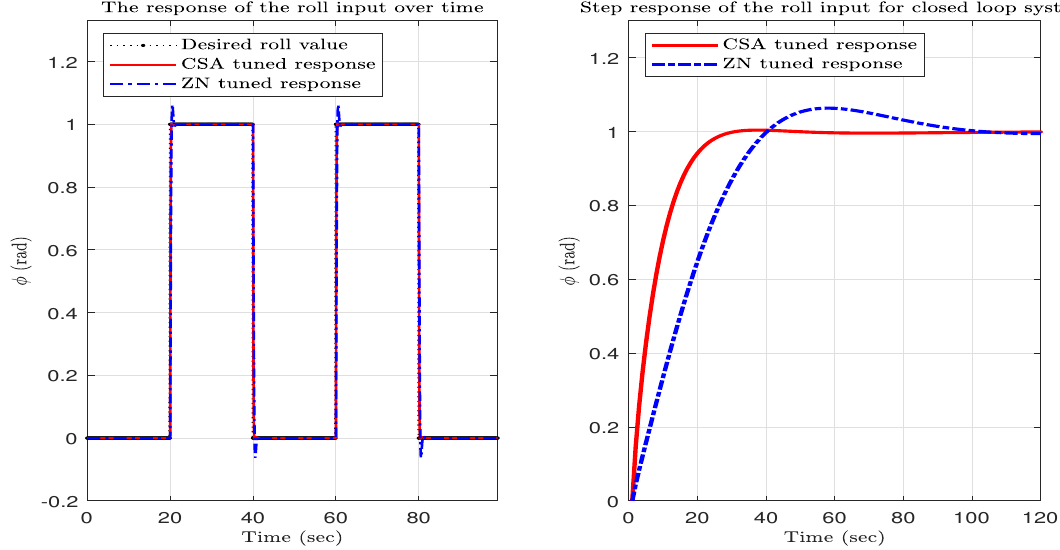
Figure 15. Simulated output responses of the roll input of a quadcopter using CSA and ZN